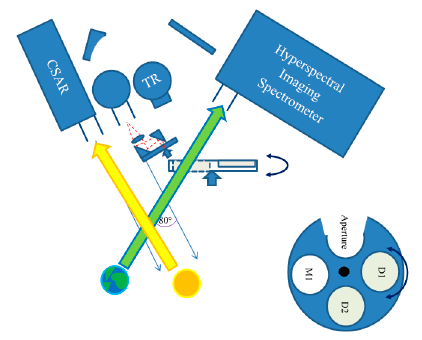
Figure 13. Measurements of the Earth and Sun.